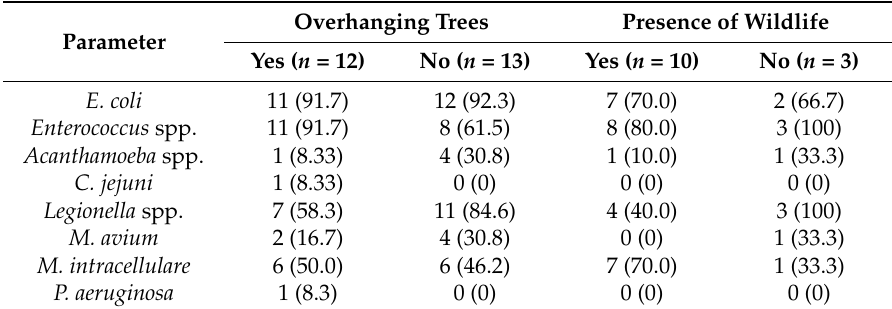
Table 5. Number of microbiological detections for sites where overhanging trees ( n = 12) or presence of wildlife ( n = 10) were observed (percentage of total reported yes or no responses in each survey category that had positive microbiological